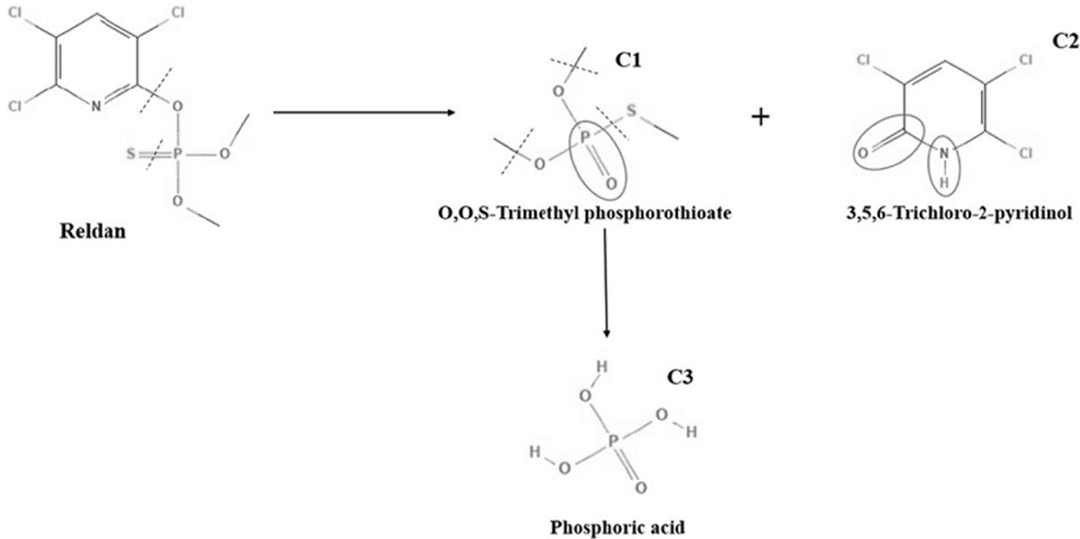
Figure 4. Chlorpyrifos degradation pathway proposed by Yehia et al. [53]. Obtained permission, license number: 5386981096650.